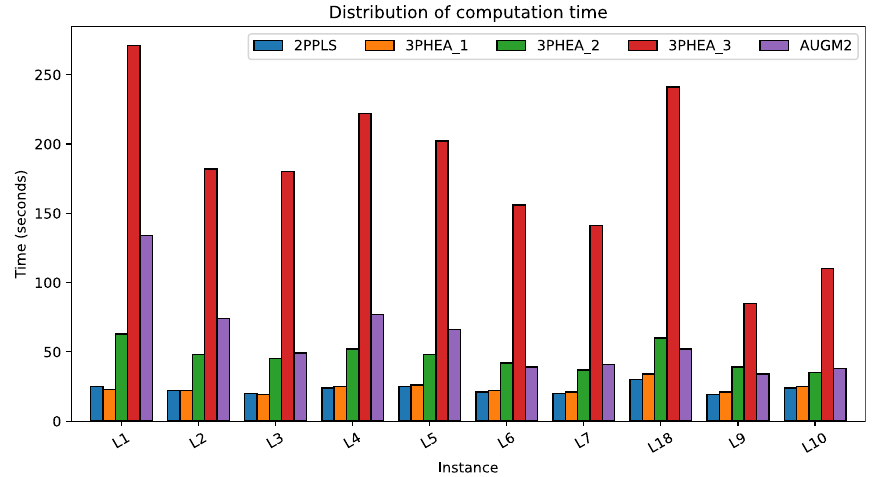
Figure 6. Distribution of computation time of different algorithms for datasets (Lust and Teghem 41 ).